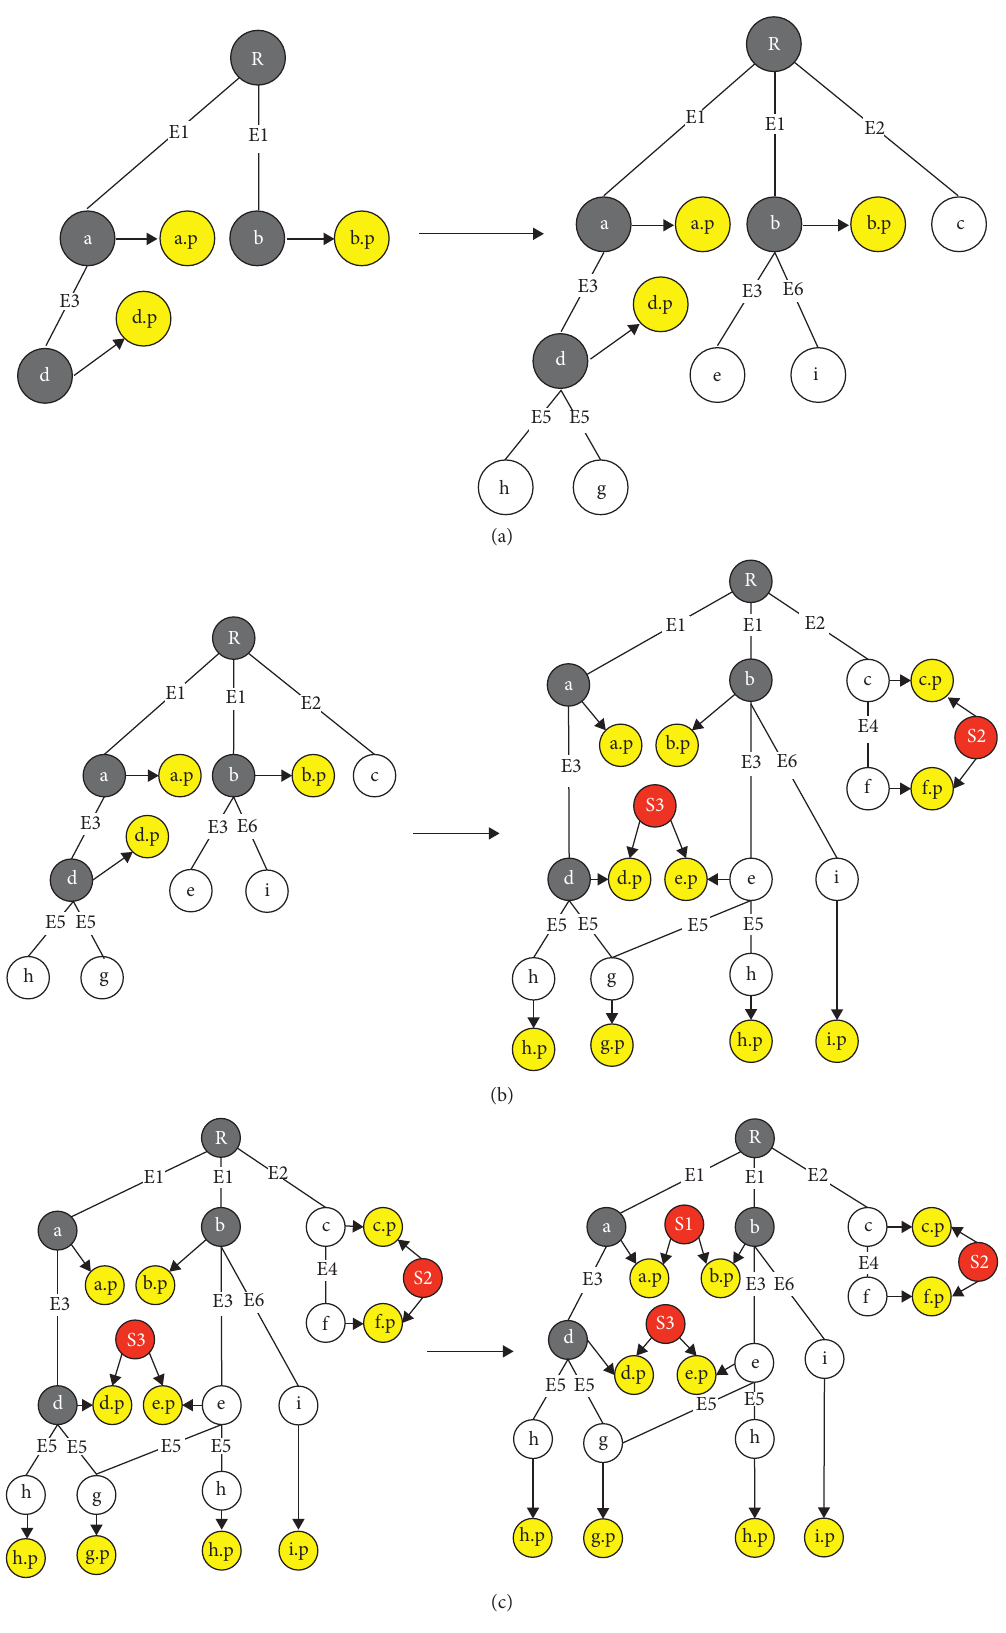
Figure 12: The steps of IFC merging: (a) first step of merging, (b) second step of merging, and (c) third step of